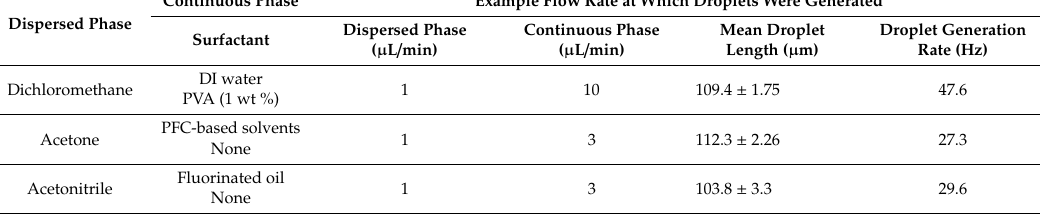
Figure 3. Images showing the microfluidic flow at the cross-junction area for ( a ) dichloromethane, ( b ) Acetone, ( c ) Acetonitrile. The flow rates of the dispersed and continuous phases (µL/min) were ( a ) 1 and 10, ( b ) 1 and 3, and ( c ) 1 and 3, respectively. The magnification of microscope was 10×. Table 2. Typical flow conditions for generating droplets of some organic solvents that are harmful to resins having high chemical resistance and their carrier combinations. The sample size of mean droplet length measurement was 30 droplets.